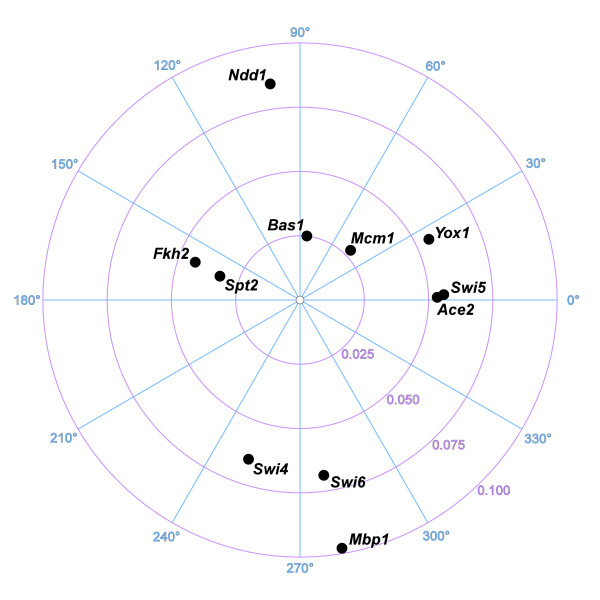
Asymptotic magnitudes and phases of transcription factor α-coefficients. We perform a dynamical analysis of our 7-minute time-translation matrix to identify the mode that corresponds to the long-term oscillatory behavior of our system. For this mode, we compute the amplitudes and phases that describe the α-coefficients of each factor. The cell cycle proceeds clockwise. Relative to Figure 1, this figure is rotated by approximately 180°.